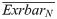
Evaluation plots for PP1.Upper panel: grbarN plotted against ExrbarN¯ along the population gradient for both population margins (red and blue lines). The blue line suggests a slightly higher grbarN along the gradient. Lower panel: HCA dendrogram suggests defining only one responder chronology, however with weak indications of sub-populations, probably caused by noise similarity. HCA labels indicate to which cluster each RWS belongs (here each belonging to cluster 1), while their colours relate to their position within the known gradient. As no gradient exists within PP1, the colours are mixed randomly.